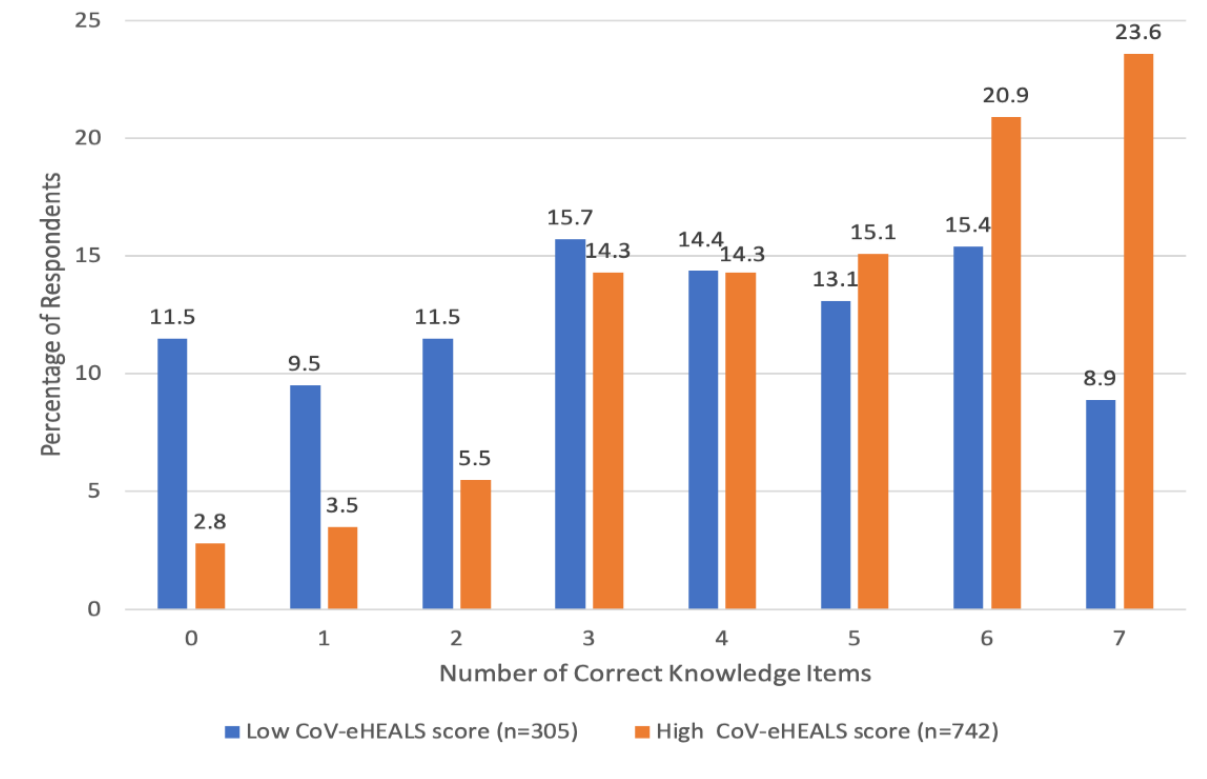
Figure 1. Number of correct knowledge items by coronavirus-related eHealth literacy.